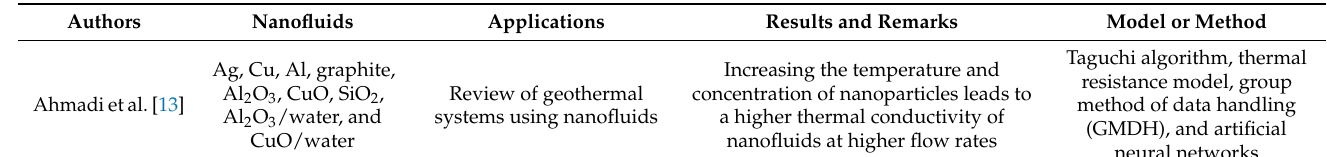
Table 1. Summary of theoretical and numerical studies on heat exchanger pipes using